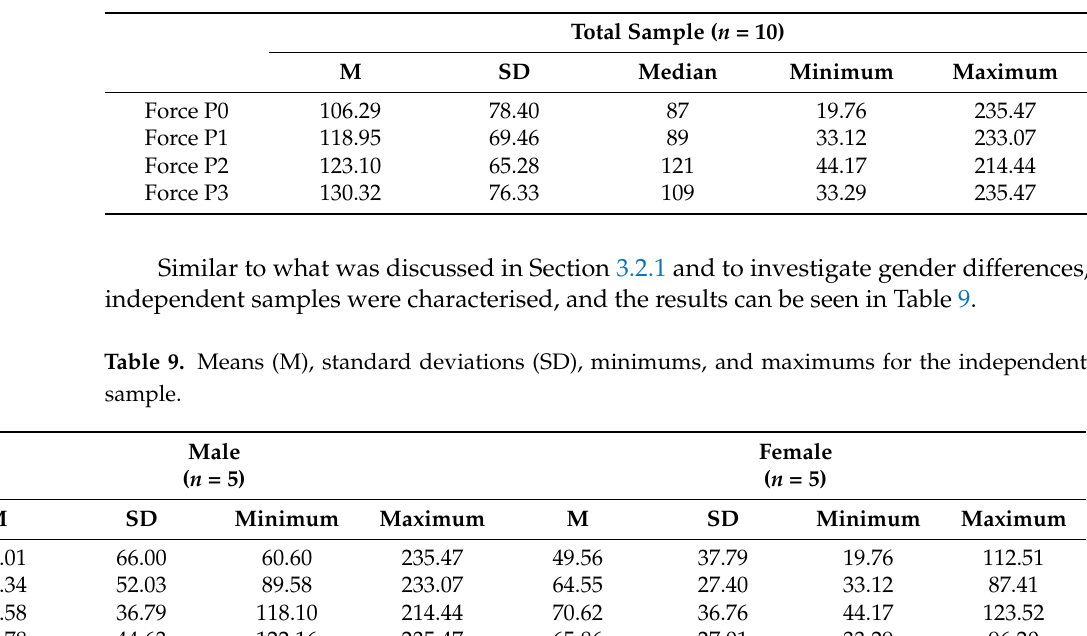
Table 8. Means (M), standard deviations (SD), minimums, and maximums for the total sample forces for the patients.